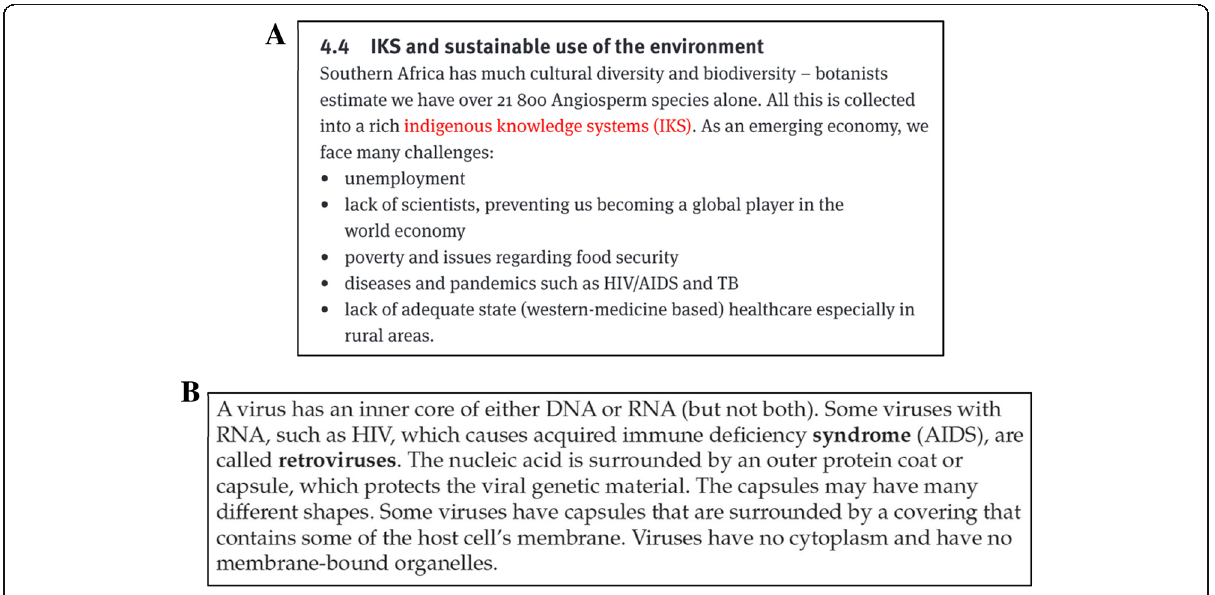
Fig. 1 a , b Extracts from Via Africa Life Sciences (Bowie et al., 2012, p. 280) and Solutions for All (McKay et al., 2012, p. 5) demonstrating how HIV/AIDS content is integrated into different